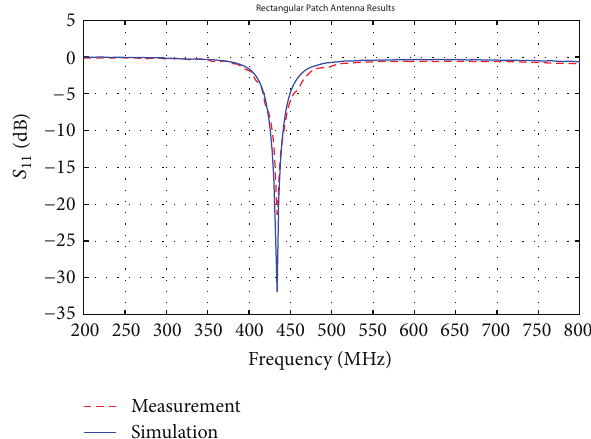
Figure 3: Simulation (solid line) and measurement (dashed line) S 11 values for patch antenna.